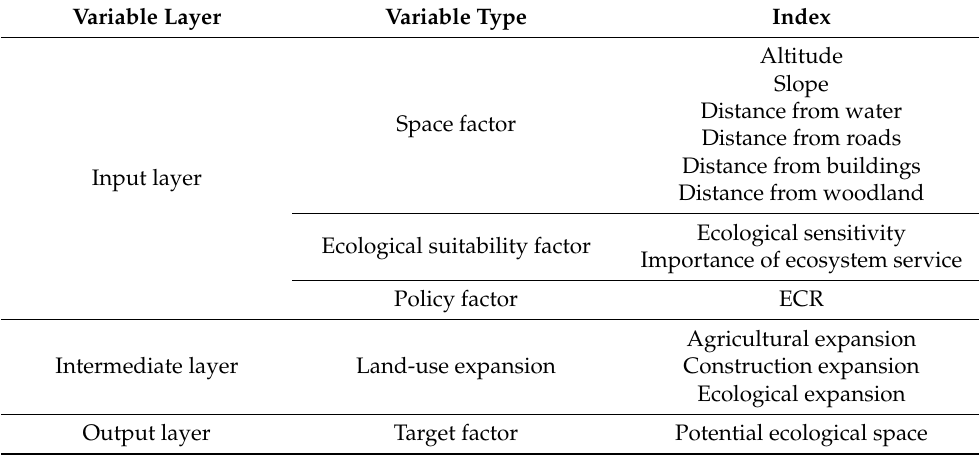
Table 1. Index of rural ecological space prediction